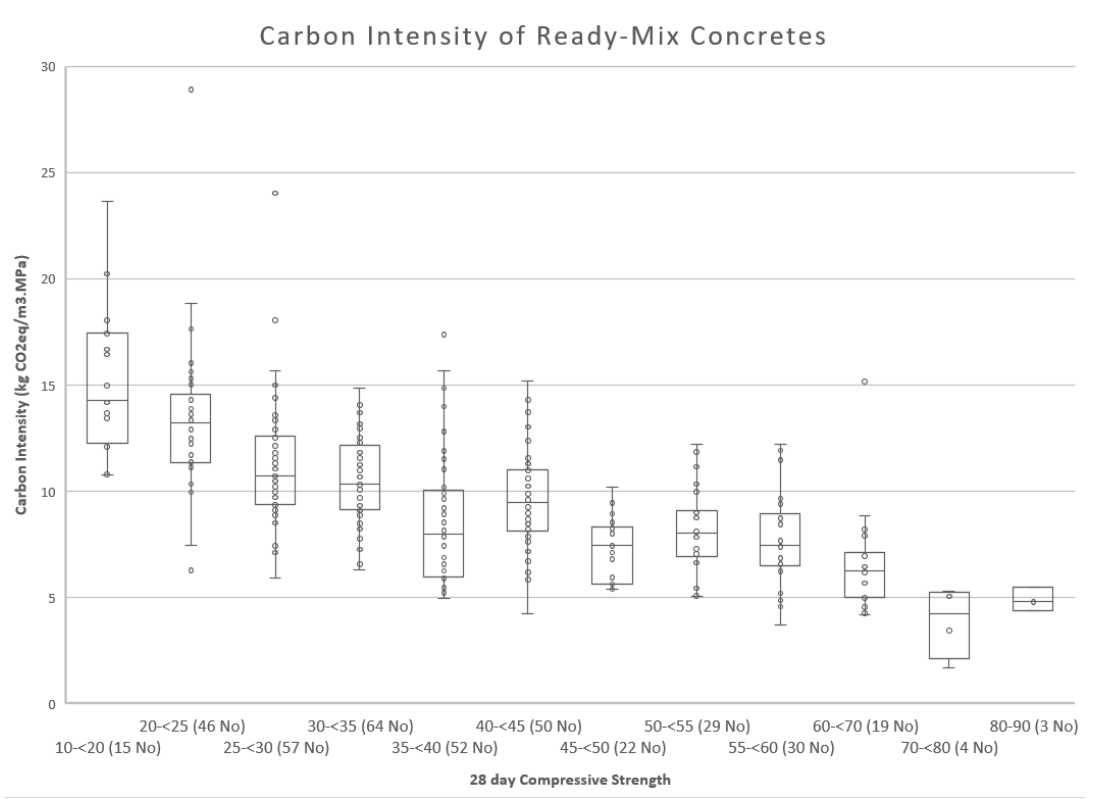
Figure 4. Box and Whisker Graph showing mean, upper and lower quartiles for Carbon Intensity ready-mix concretes, source